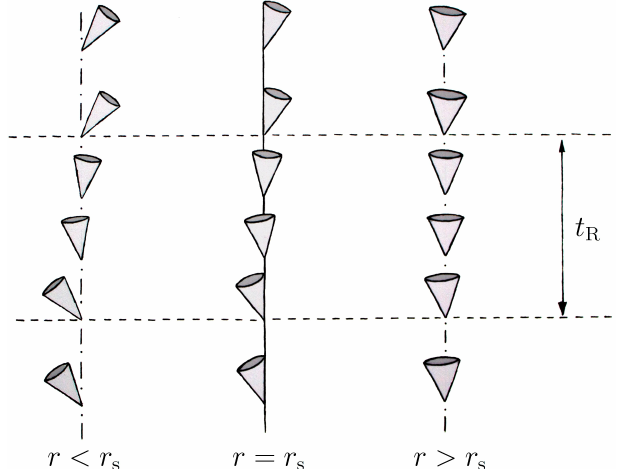
Figure 1. Transition from the black-hole patch to the white-hole patch by using a smooth interpolation with characteristic time scale t R . The qualitative behavior of light cones for different values of the radial coordinate is